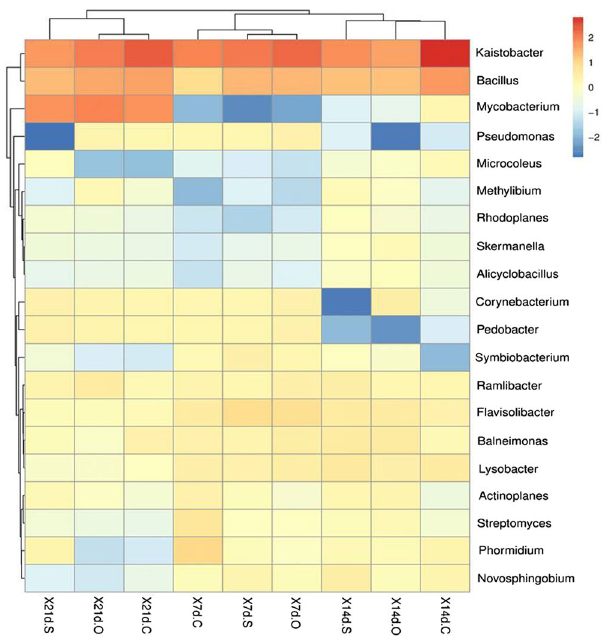
Figure 5. The heat map in relative abundances of top 20 most abundant genera in different cultivation